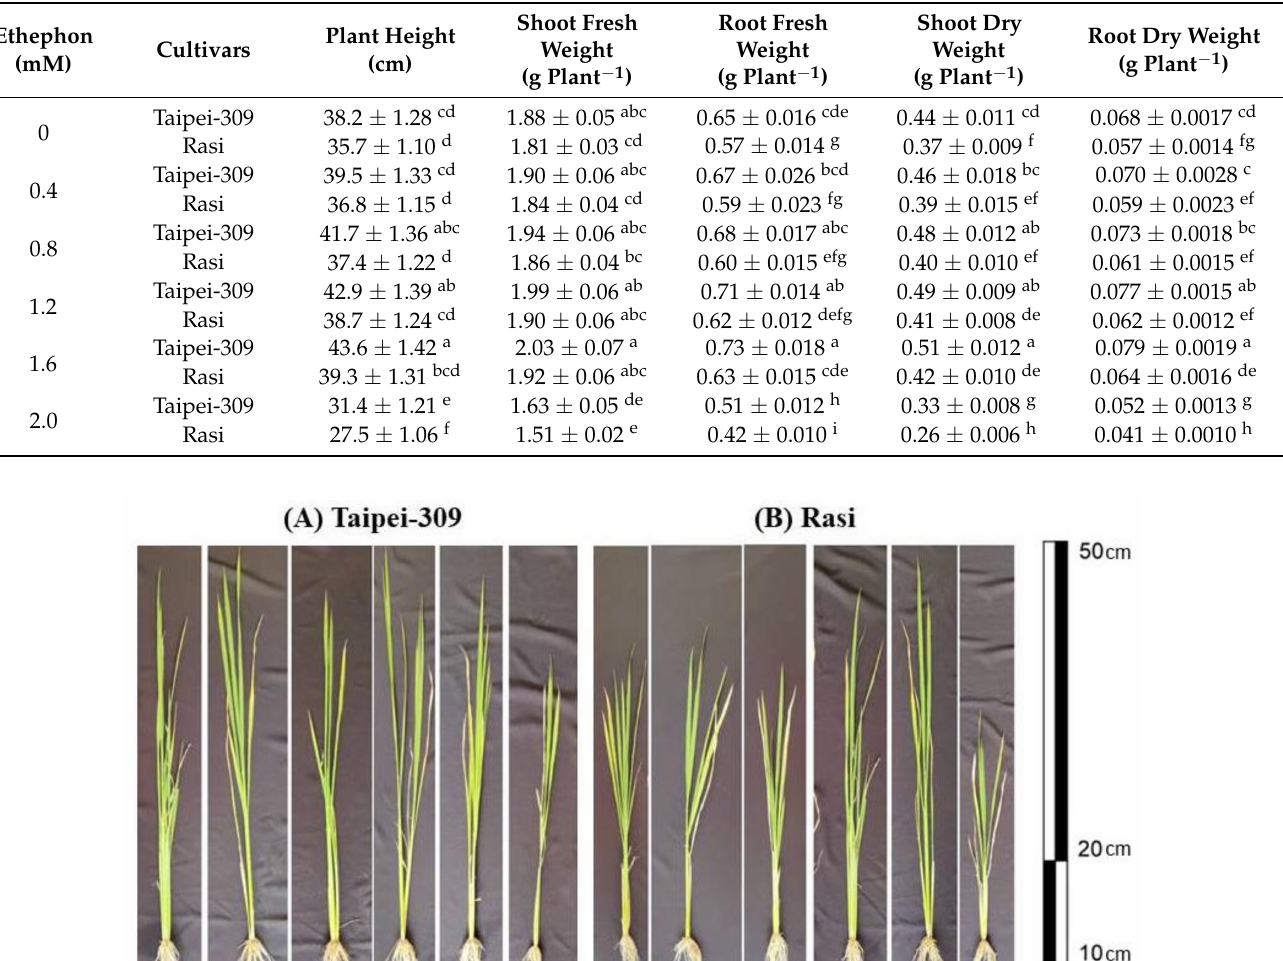
Table 2. The influence of foliage treated with 0, 0.4, 0.8, 1.2, 1.6, or 2.0 mM ethephon at 15 DAS on plant height, shoot fresh weight, root fresh weight, shoot dry weight, and root dry weight of Taipei-309 and Rasi cultivars of rice ( Oryza sativa L.) at 30 DAS. Data are presented as treatment means ± SE ( n = 4). Data followed by the same letter are not significantly different by the LSD test at p < 0.05. DAS, days after sowing.